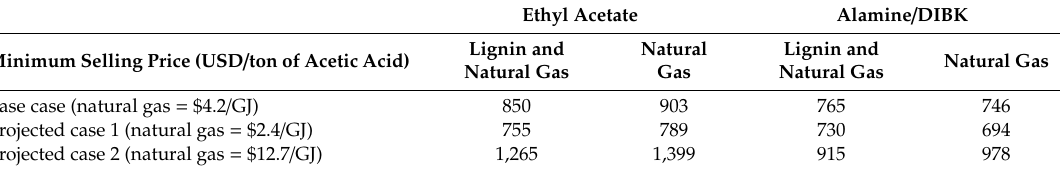
Table 7. The minimum selling price of acetic acid for base case scenario (natural gas = 4.2 USD / GJ) and two projected cases (natural gas = 12.7 USD / GJ and 2.4 USD / GJ) for a biorefinery with a capacity of 120,650 tons / year. Minimum Selling Price (USD / ton of Acetic Acid)